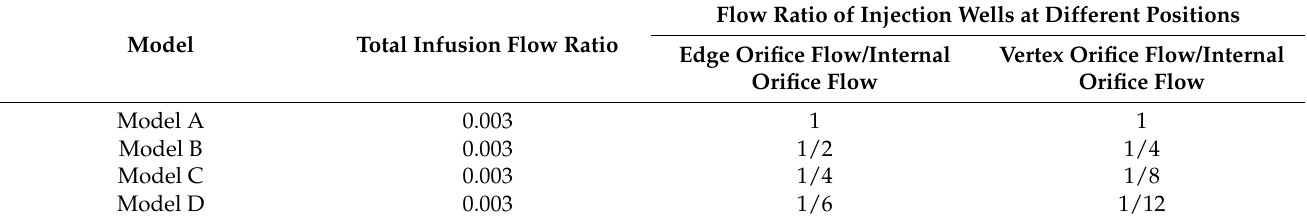
Figure 2. Comparative study process of leaching range control effect. Table 1. Conditions of the comparison